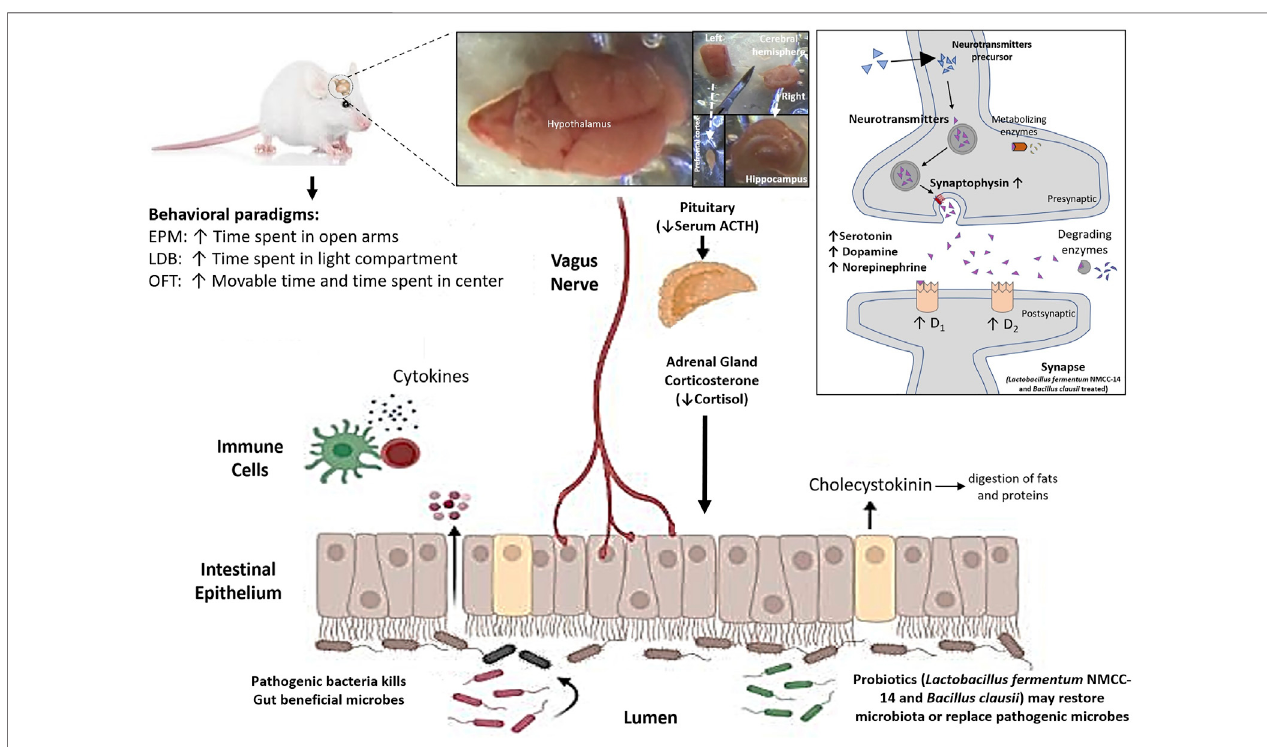
FIGURE 7 | Effects of Lactobacillus fermentum NMCC-14 (10 10 CFU/day, p.o) and Bacillus clausii (10 10 CFU/day, p.o) through the gut – brain axis on monoamine levels (serotonin, dopamine, and norepinephrine), mRNA expression of synaptophysin and dopamine receptor subtypes (D 1 and D 2 ) in the hippocampus and prefrontal cortex of mice brains, and blood ACTH and cortisol levels in restraint-stressed and normal mice. Note that ↑ shows increase and ↓ shows decrease, and the abbreviations used are EPM , elevated plus maze, LDB , light dark box, and OFT , open fi eld